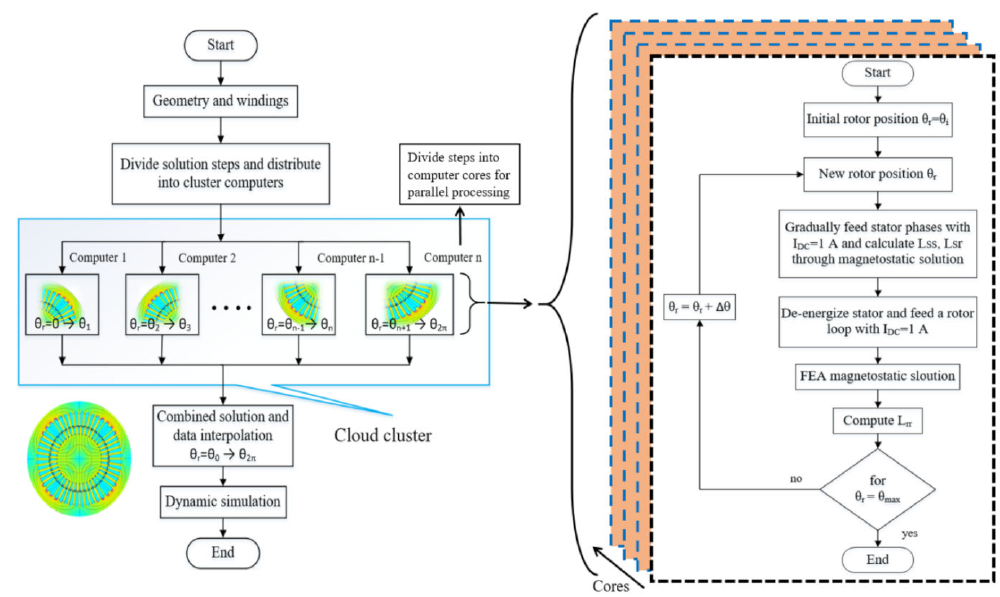
Figure 3. The division of rotor steps among various computers and their cores for parallel computation and the procedure of inductances